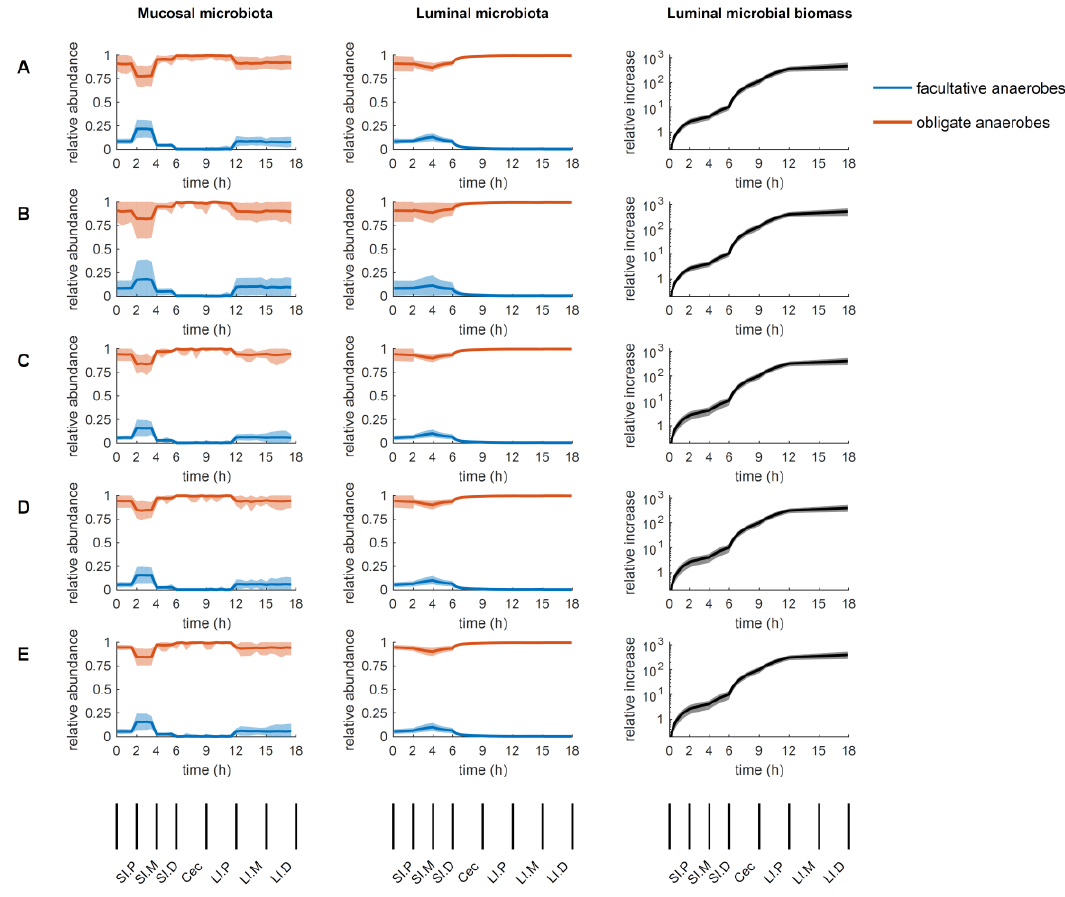
Figure 7. Varying the maximum specific oxygen uptake rates of aerobes, 𝐿𝐵 𝑂𝑈𝑅𝑘 . ( A ) 2 mmol gdw − 1 h − 1 , the default value. ( B ) 1 mmol gdw − 1 h − 1 . ( C ) 5 mmol gdw − 1 h − 1 . ( D ) 10 mmol gdw − 1 h − 1 . ( E ) 20 mmol gdw − 1 h − 1 .